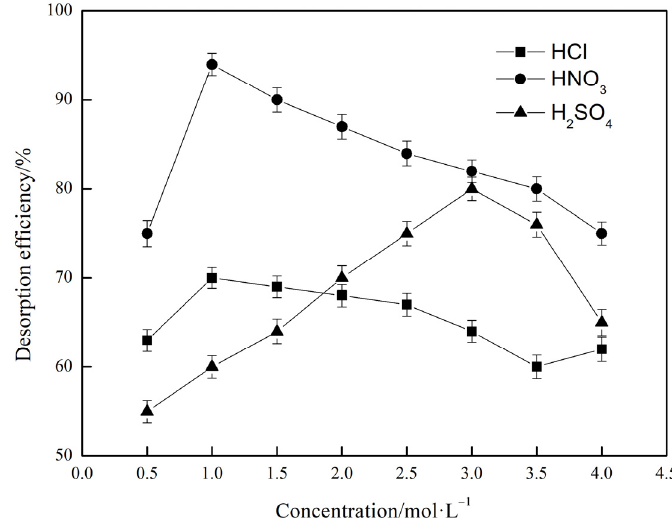
Figure 6. Effect of type and concentration of eluent on the desorption efficiency.